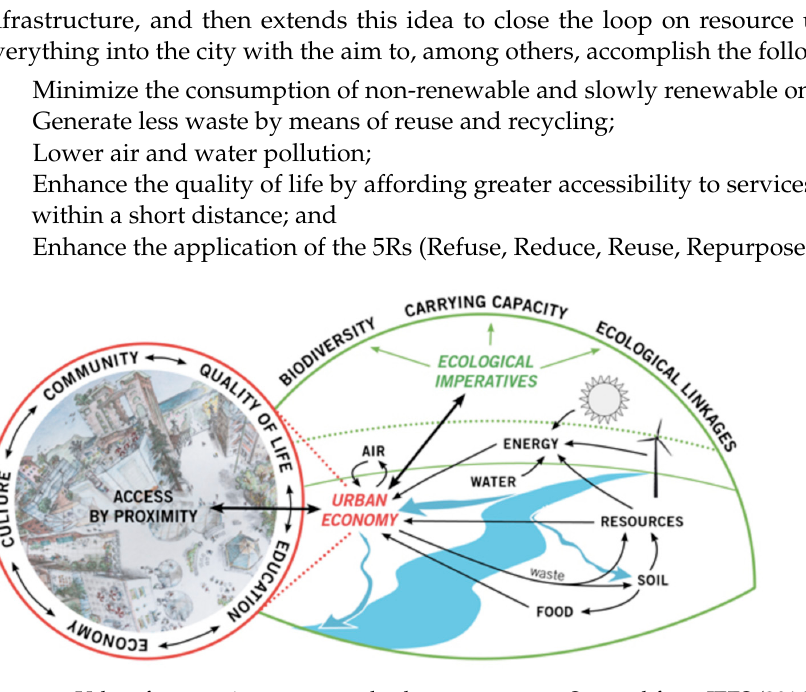
Table 1. The multidimensional benefits of proximity for sustainability. Adapted from Bibri [60].